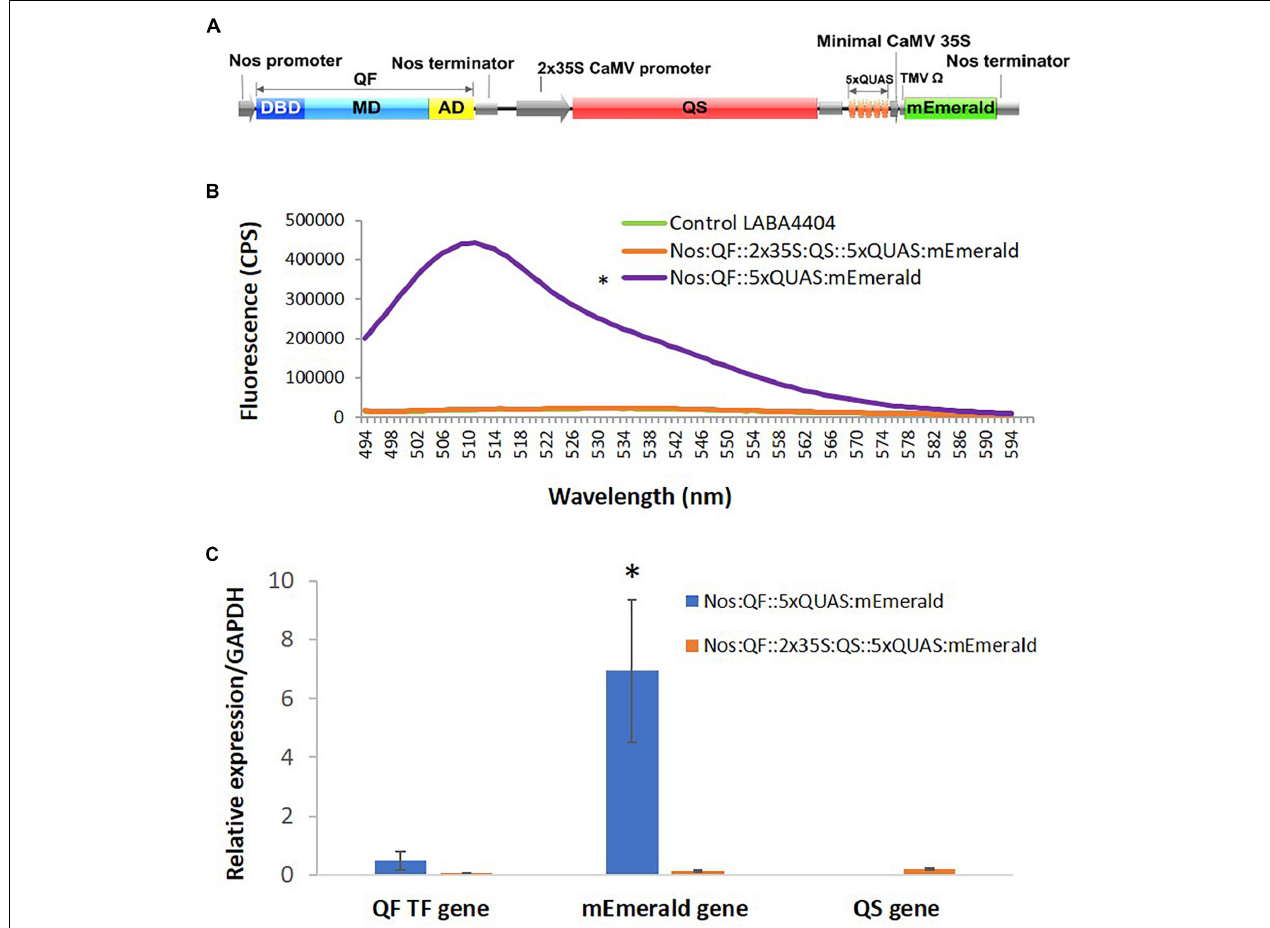
FIGURE 6 | Suppression of QF by expression of QS. (A) Schematic of the Q-system suppression vector: Nos:QF:2 × 35S:QS:5xQUAS:mEmerald. DBD, DNA binding domain; MD, middle domain; AD, activation domain; QS, Q-system suppressor. (B) Spectral analysis of N. benthamiana transiently infected leaves expressing the mEmerald reporter. Statistical significance was determined for all data points across the spectrum using one-way repeated measures ANOVA, with post hoc analysis using Tukey HSD. Asterisk (*) indicate significant difference compared to plants infiltrated with LBA4404 as a control ( p < 0.05). Data represent mean ± standard error of three independent experiments ( n = 3). Three technical replicates were collected from each independent experiment to account for variability in the sample. (C) Variation in expression levels of mEmerald and QF in plants transiently infected with the Q-system activation construct (Nos:QF:5xQUAS:mEmerald) and Q-system QS suppression construct (Nos:QF:2 × 35S:QS:5xQUAS:mEmerald), as determined by qRT-PCR. The relative levels of the transcripts were normalized to expression of N. benthamiana g lyceraldehyde 3-phosphate dehydrogenase (GAPDH). There was no significant difference in the expression of the QF transcription factor between the constructs ( p > 0.05); however, there was a significant difference (* p < 0.05) in mEmerald expression. This confirms that the reduced expression was due to suppression of QF by QS. qRT-PCR was performed on tissue collected from three independent experiments ( n = 3), with three technical replicates collected per